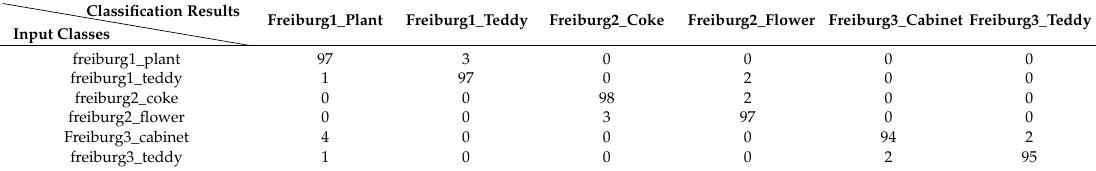
Table 1. The confusion matrix of integrating multiple model-specific CNN object detectors for detecting all objects under